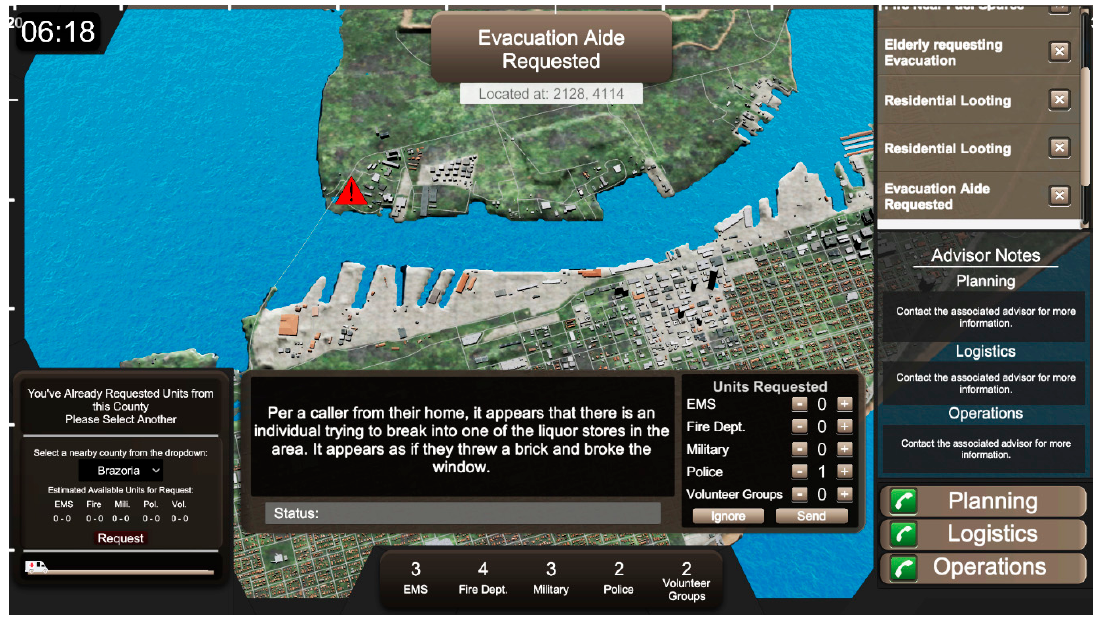
Figure 8. The Project Emergency Operations Center (EOC) prototype game that was developed based on results and experiences from developing project Lily Pad.